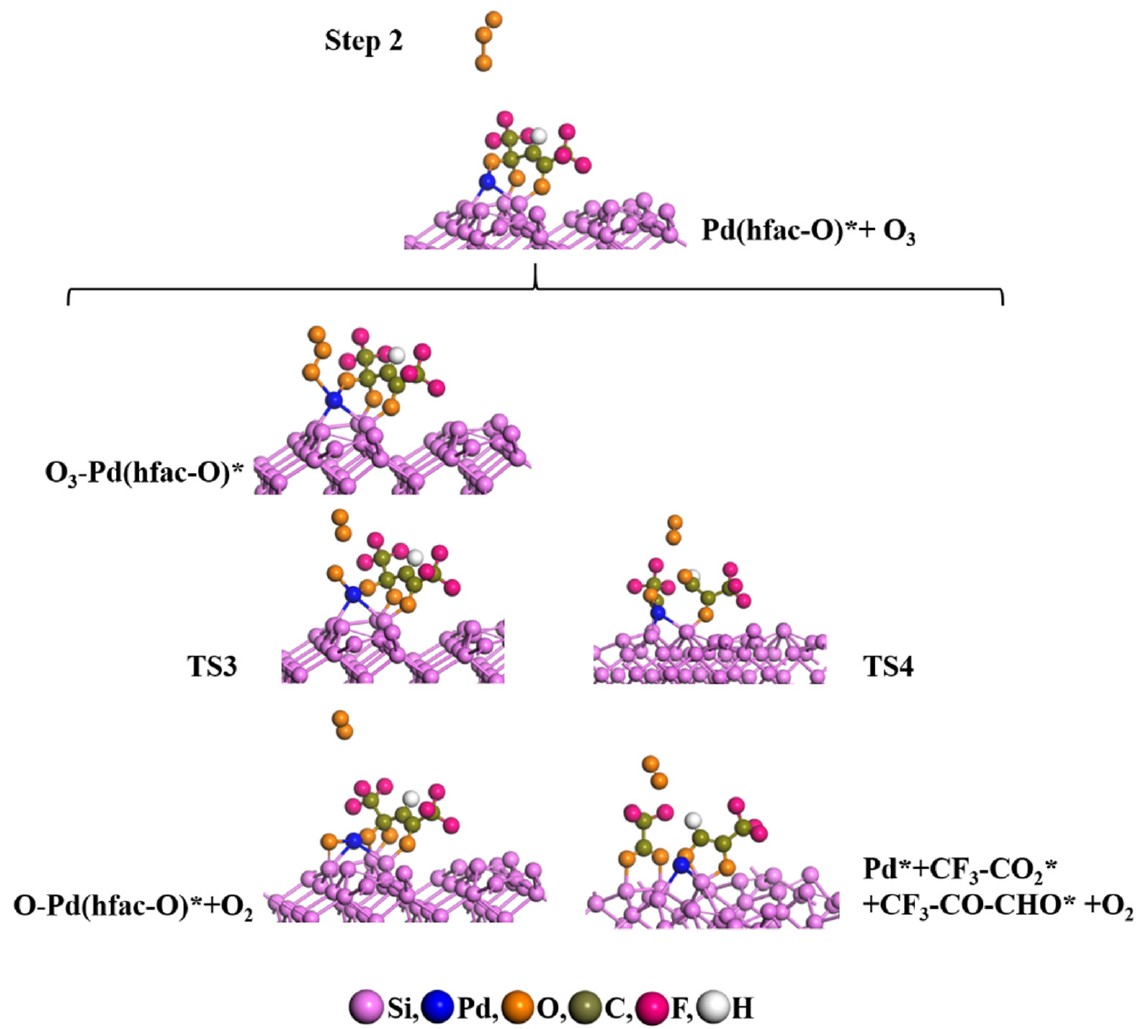
Figure 5. Reaction between Pd(hfac-O)* and ozone on the clean Si (100) surface represented by snapshots.